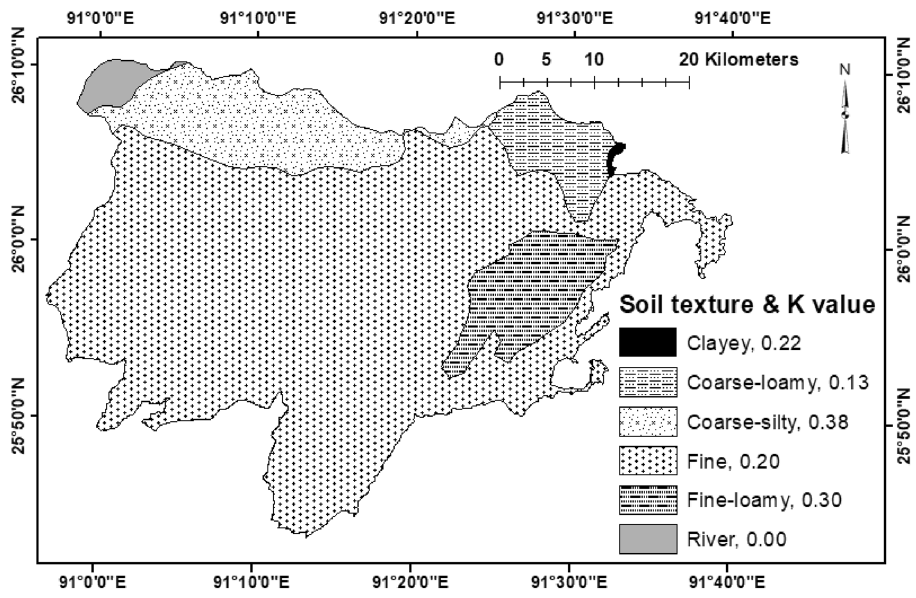
Case Studies Fig. 3 Soil texture map and corresponding erodibility fac- tor (K)